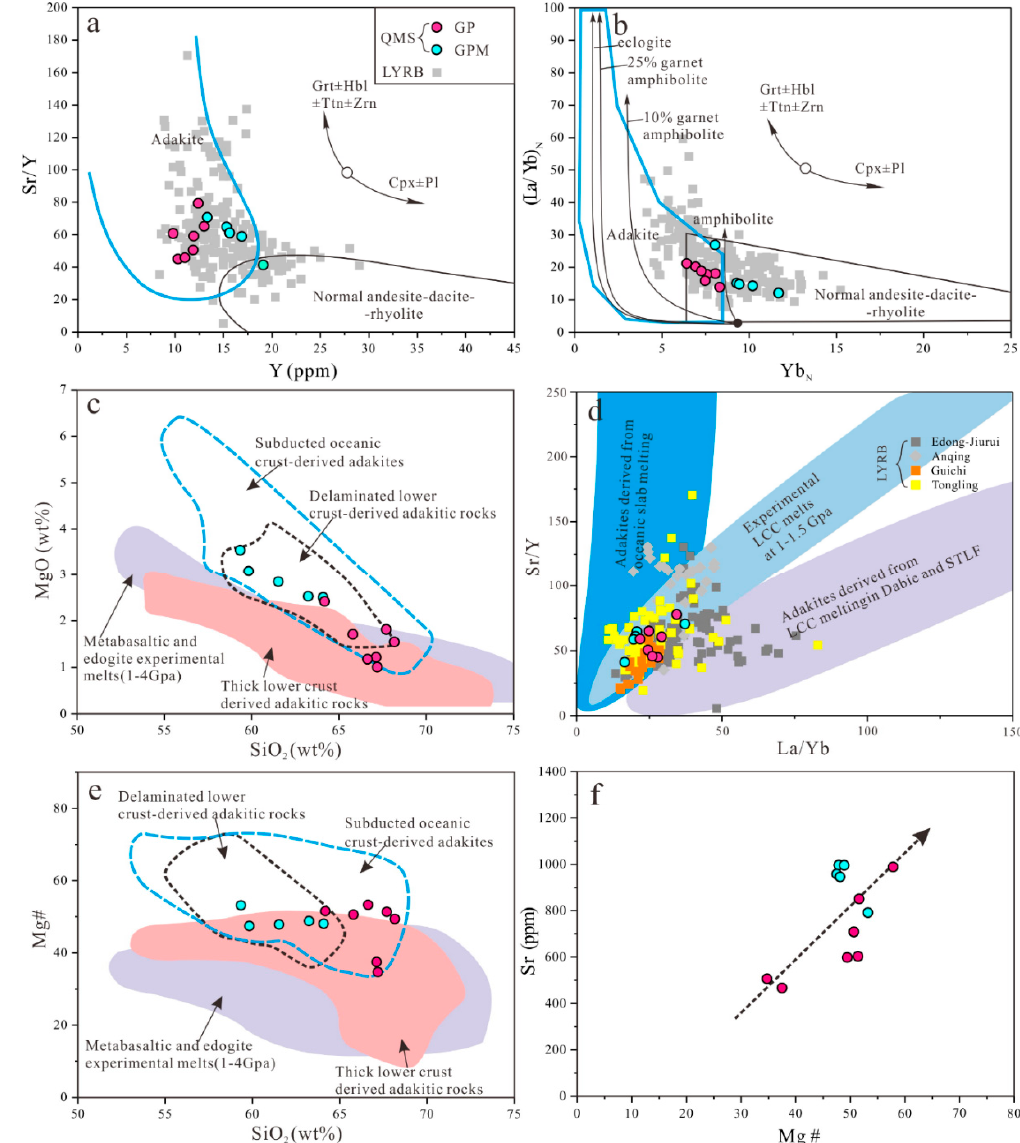
Figure 7. ( a ) Sr/Y–Y (after [31]), ( b ) Sr/Y vs. (La/Yb) N classification diagram (after [31]), ( c ) MgO vs. SiO 2 , ( d ) Sr/Y vs. La/Yb (after [32]), ( e ) Mg# vs. SiO 2 , and ( f ) Mg# vs. Sr for the Qiaomaishan intrusive rocks and other MLYRB adakitic rocks. The area of subducted oceanic adakites is from [9,17], the area of experimental lower continental crust (LCC) melts (1–4 GPa) is from [33], the area of delaminated lower crust-derived adakitic rocks is from [34,35], and the area of thick lower crust-derived adakitic rocks is from [36]. Data for MLYRB adakitic rocks are from [9,16,32,37]. The REEs of the Qiaomaishan intrusive rocks exhibit strong enrichments in LREEs relative to HREEs as well as different LREE/HREE ratios (11.9–15.2 for GP, and 9.9–14.9 for GPM, Table S1) with slightly negative Eu anomalies (0.86–0.93). GP has systematically lower REE contents and more depleted HREE than GPM (Figure 8a). The intrusive rocks share similar normalized trace element patterns (Figure 8b) characterized by an enrichment of large ion lithophile elements (LILEs; e.g., Ba, Rb, and Th), and depletion of high field strength elements (HFSEs) with positive anomalies of Sr and Pb and pronounced negative anomalies of Ta, Nb, and Ti (Figure 8b). However, GPM has systematically higher Cr (27.6–40.5 ppm), Ni (15.84–31.39), and V (99.4–138.0) contents than GP (Cr: 7.6–21.5 ppm, Ni: 4.48–20.12 ppm, and V: 55.9–77.7).